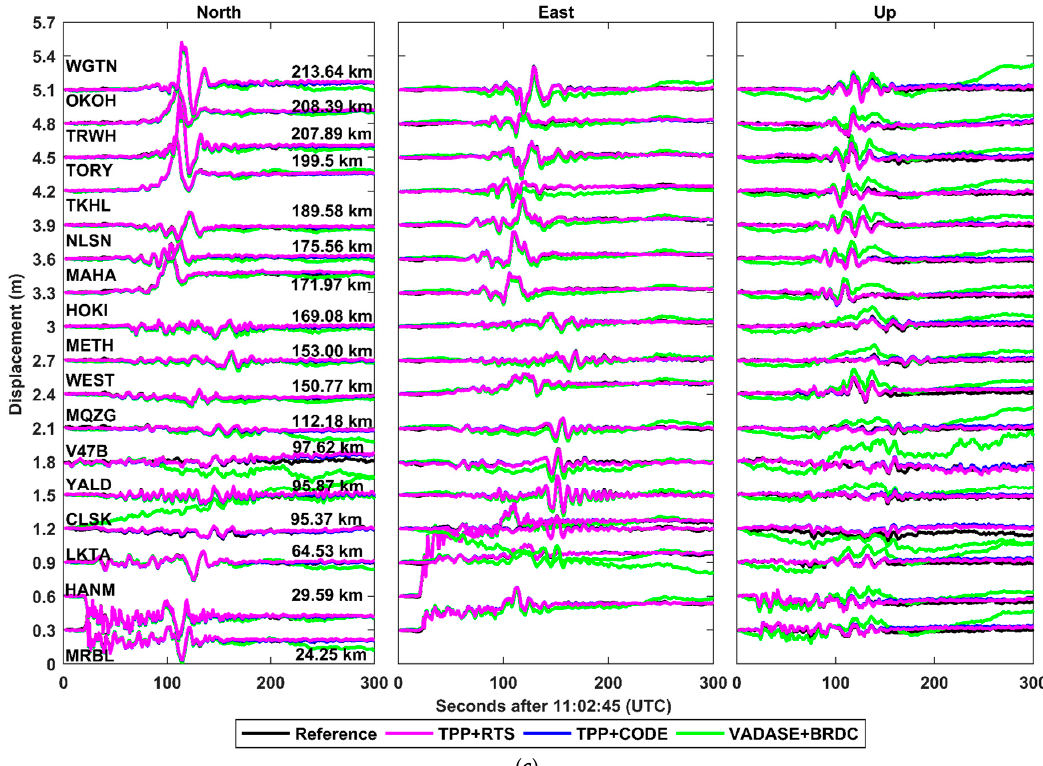
Figure 10. The coseismic displacement waveforms in north, east and up directions derived from different schemes at the selected 51 stations with the epicentral distances ranging from 270–400 km ( a ), 210–270 km ( b ) and 24–210 km ( c ).